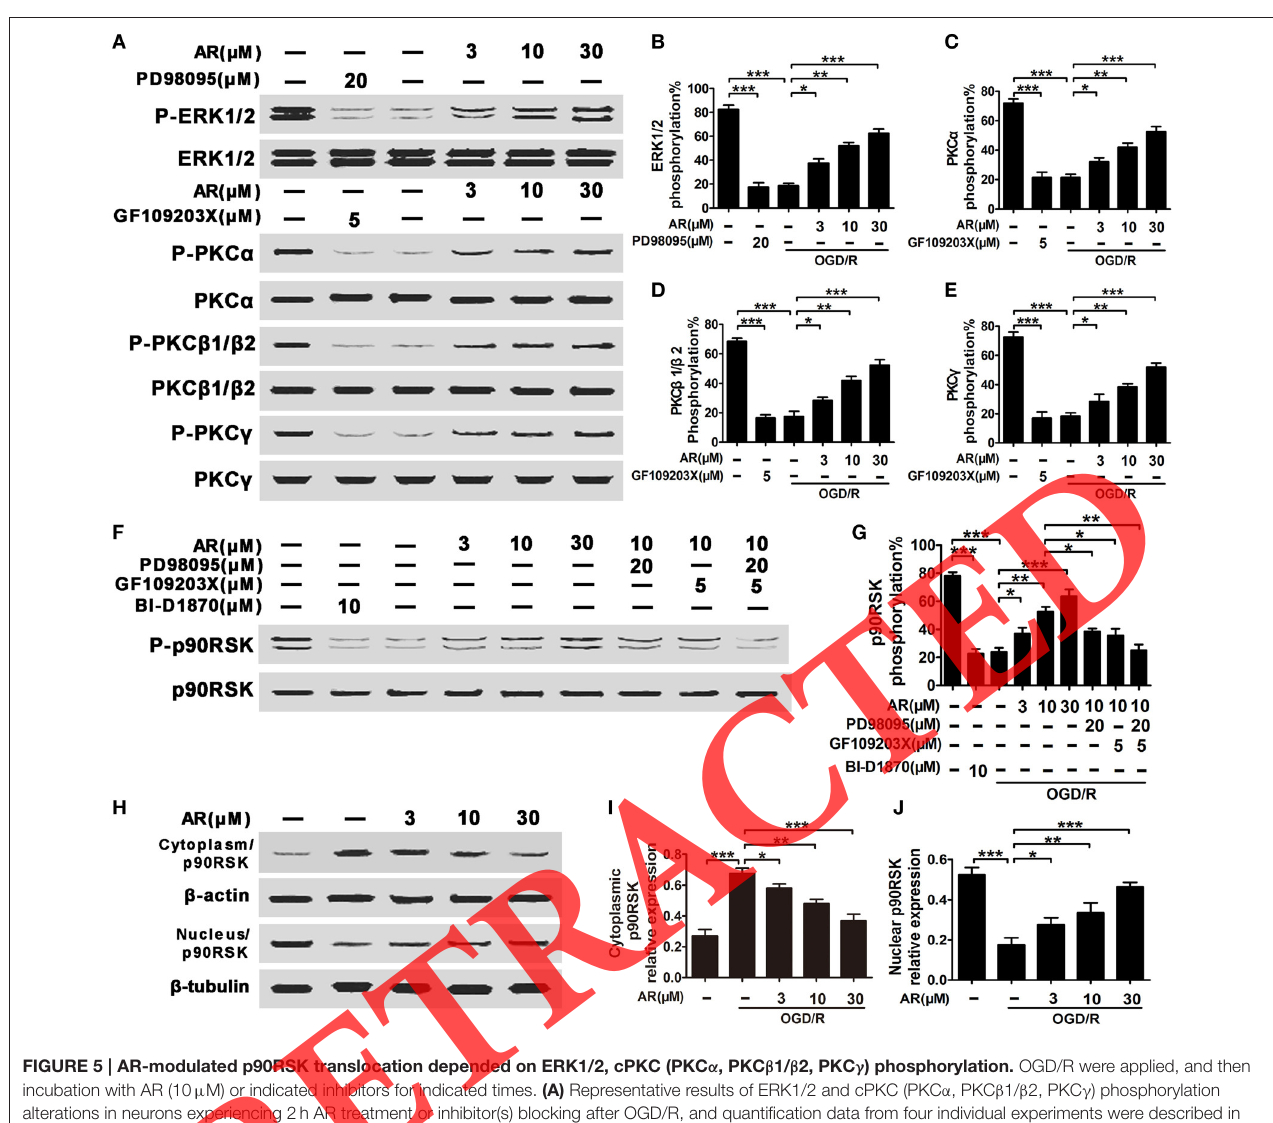
FIGURE 5 | AR-modulated p90RSK translocation depended on ERK1/2, cPKC (PKC α , PKC β 1/ β 2, PKC γ ) phosphorylation. OGD/R were applied, and then incubation with AR (10 µ M) or indicated inhibitors for indicated times. (A) Representative results of ERK1/2 and cPKC (PKC α , PKC β 1/ β 2, PKC γ ) phosphorylation alterations in neurons experiencing 2h AR treatment or inhibitor(s) blocking after OGD/R, and quantification data from four individual experiments were described in (B) ERK1/2, (C) PKC α , (D) PKC β 1/ β 2, and (E) PKC γ . (F) Representative result of p90RSK phosphorylation alterations in neurons experiencing 4h AR treatment or inhibitor(s) blocking after OGD/R, and this quantification data were described in (G) . (H) Representative result of p90RSK nucleus-cytoplasm distribution alterations in neurons experiencing 6h AR treatment or inhibitor(s) blocking after OGD/R, and this quantification data were described in (I,J) . Results mentioned-above were